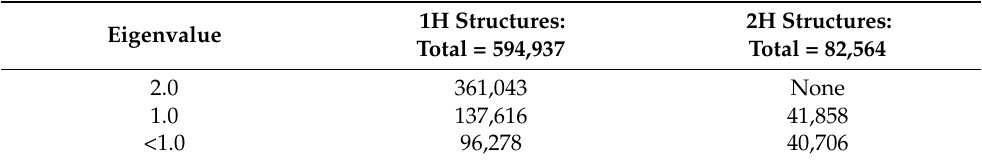
Table 1. Eigenvalue statistics: distribution of our dataset according to the second smallest Lapla- cian eigenvalue.